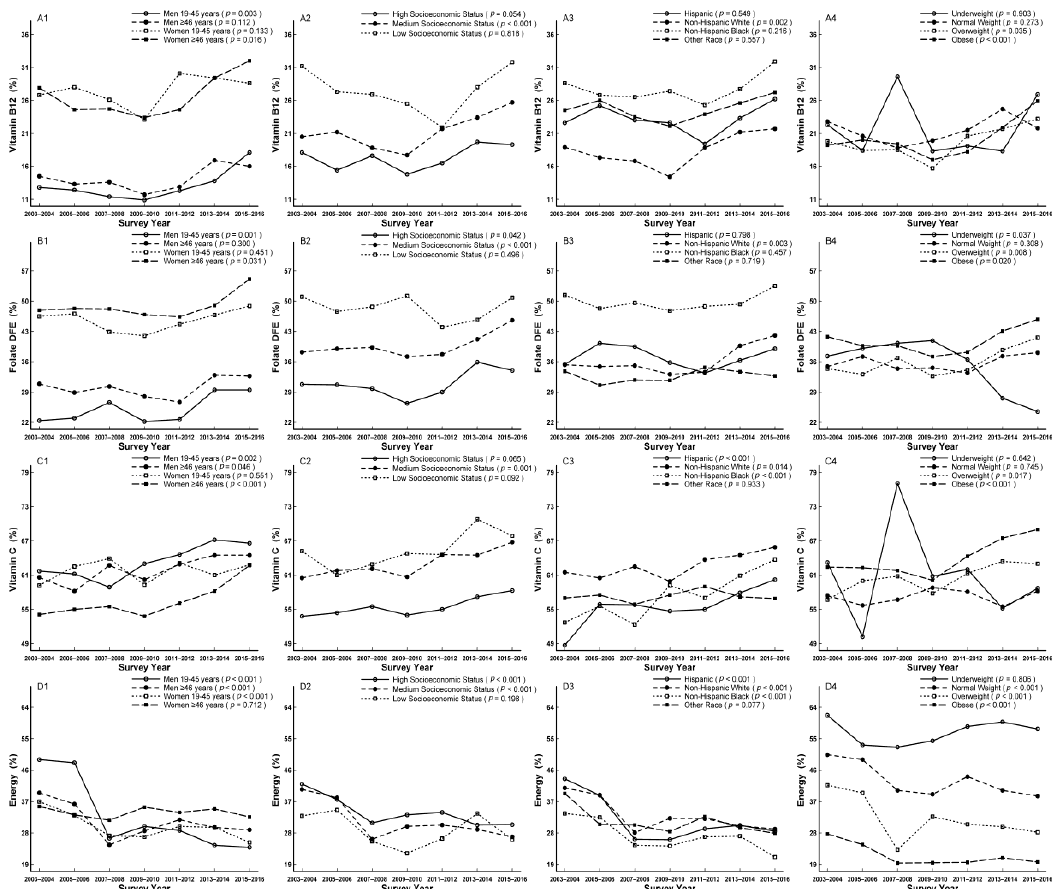
Figure 5. Trends of dietary vitamin B12 (A1 – A4), folate DFE (B1 – B4), vitamin C (C1 – C4), and energy (D1 – D4) by sex, age, socioeconomic status, race/ethnicity, and body mass index (BMI) for